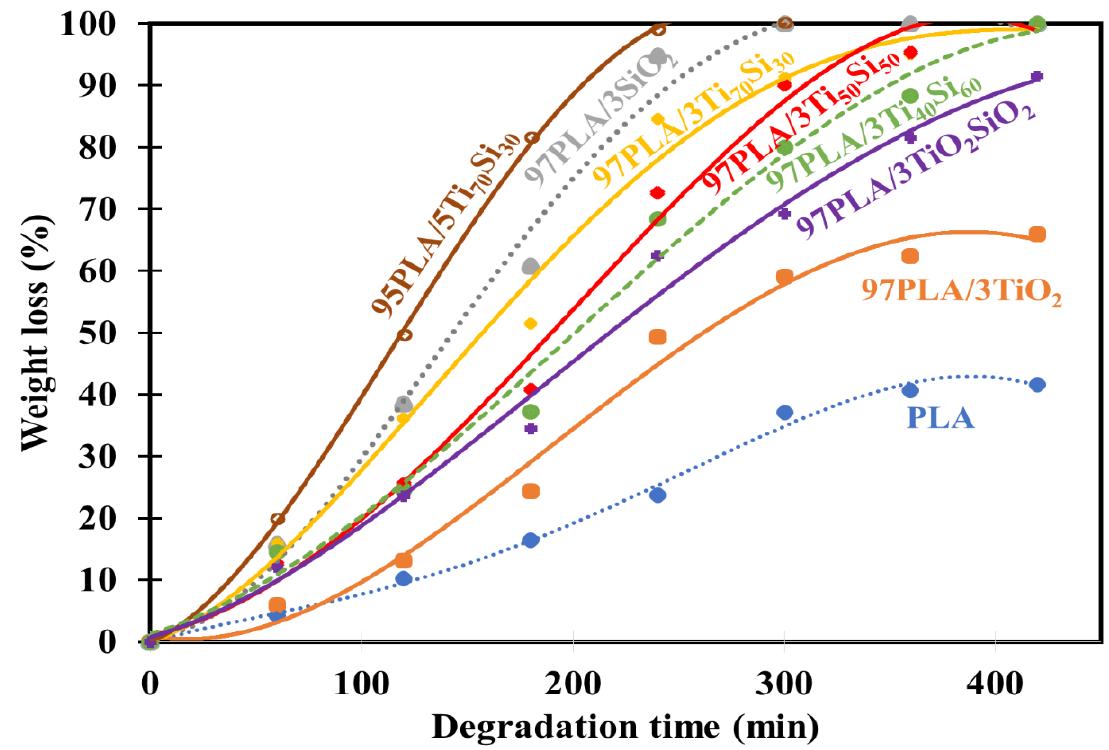
Figure 10. Weight loss of hydrolytic degradation of PLA, PLA/TiO 2 , PLA/SiO 2 , and PLA/Ti x Si y composite films as functions of degradation time.